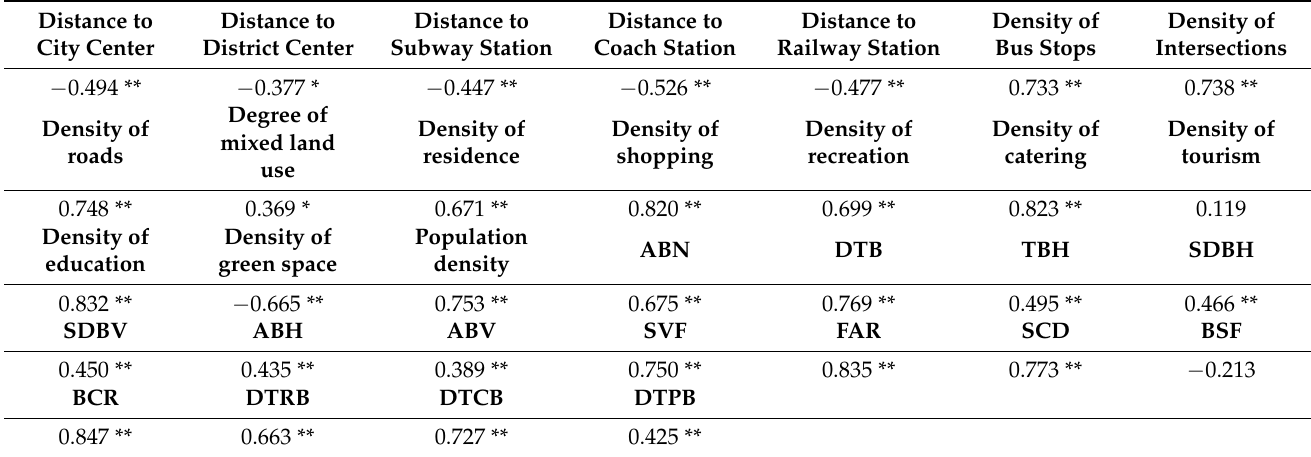
Table 3. Linear correlation between urban vitality and each independent